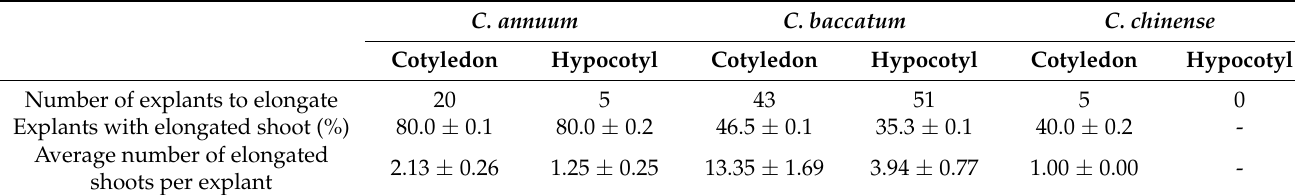
Table 8. Elongation of shoots of C. annuum , C. baccatum and C. chinense in ELG medium (supplemented with IAA, GA 3 and citric acid). Data represent the number of cotyledon and hypocotyl explants transferred to elongation medium, percentage of explants with elongated shoots ± standard error and average elongated shoots per explant ± standard deviation.